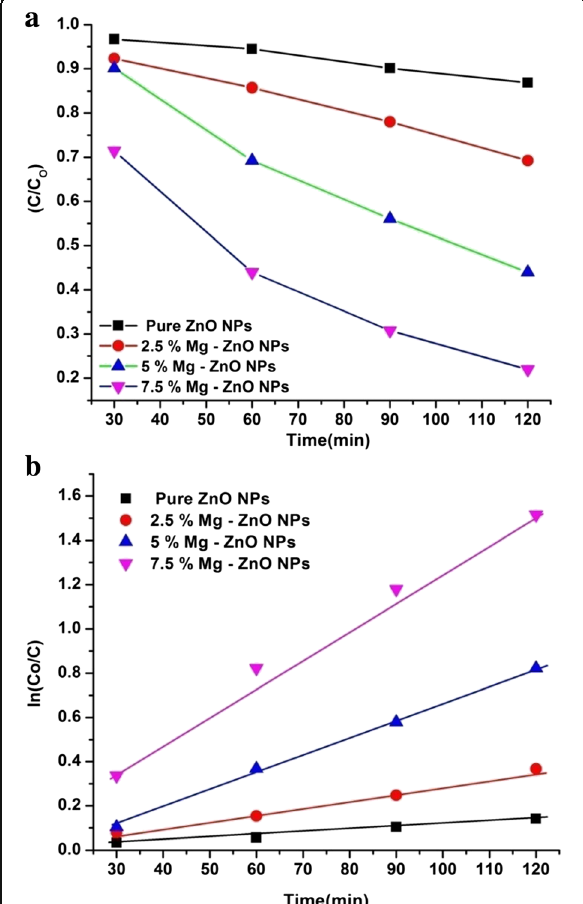
Fig. 9 ( a ) Evolution of the relative concentration of RhB as a function of the time for pure and Mg-ZnO NPs ( b ) The reaction kinetics of RhB dye degradation for pure and Mg-ZnO NPs